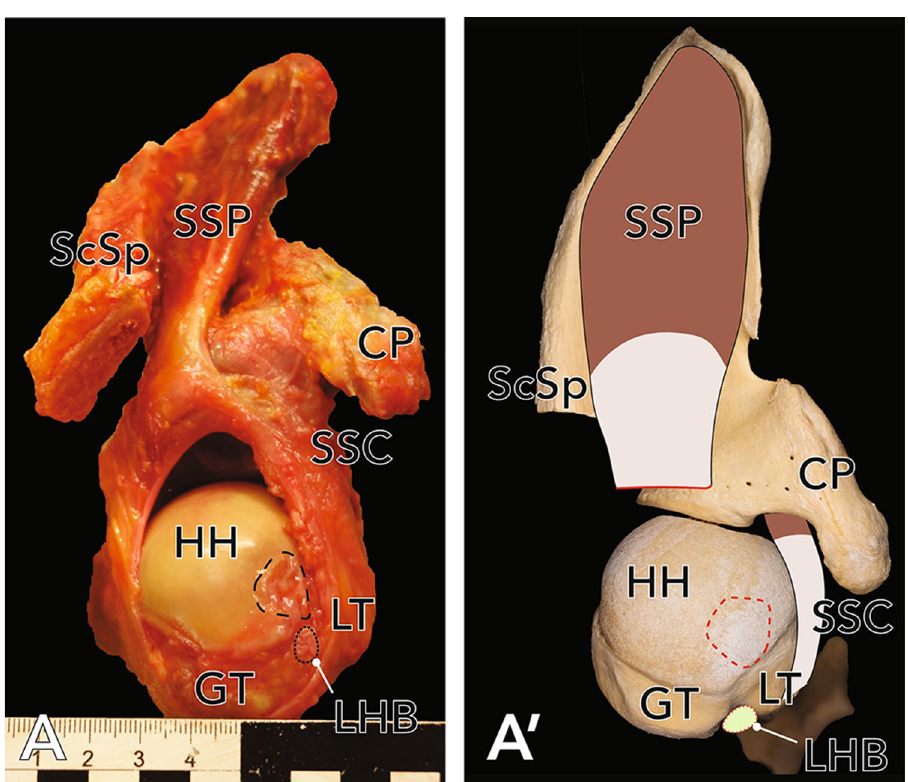
Figure 3. ( A ) Exemplary full-thickness SSP-lesion in a right shoulder, view from superior. The lesion was classified as Bateman III. In addition to the tendon tear, also a complete rupture of the CHL and of the LHB was identified. ( A ′ ) Approximation of the photographs as an overlay on humerus and scapula. Dashed line delineates an anterosuperior cartilage defect. Dotted line identifies the ruptured tendon of the LHB. HH humeral head, CP coracoid process, ScSp scapular spine, GT greater tubercle, LT lesser tubercle, SSP supraspinatus muscle, SSC subscapularis muscle, LHB long head of the biceps brachii